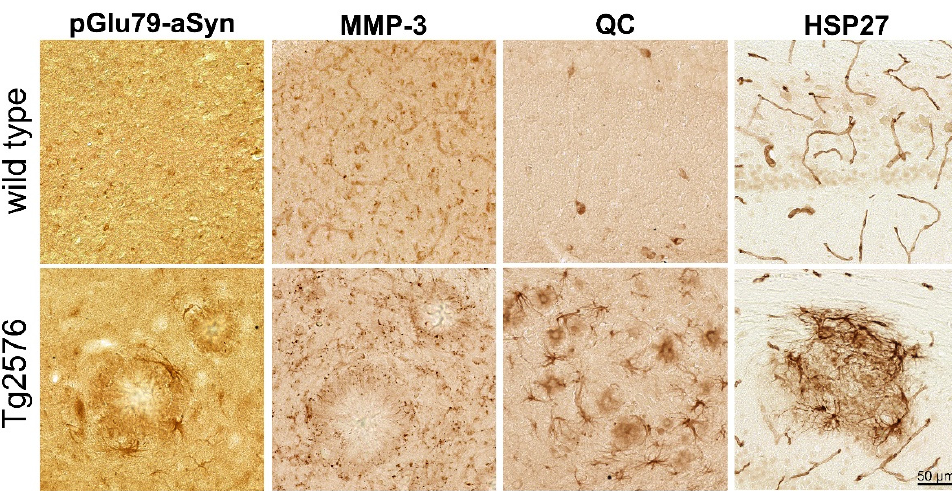
Figure 3 . Immunohistochemical detection of pGlu79-aSyn, MMP-3, QC and HSP27 in brains of wild-type and Tg2576 mice . In wild-type mouse brain ( top row ), synaptic pGlu79-aSyn, extracellular/synaptic MMP-3, QC-positive interneurons and vascular HSP27 were detected. In contrast, in Tg2576 mouse brain ( bottom row ), pGlu79-aSyn, QC and HSP27 were detected with different intensities in glial cells. MMP-3 and in addition QC and pGlu79-aSyn appeared as punctate or diffuse extracellular aggregates in the periphery of A β plaques. The examples shown are from entorhinal cortex (pGlu79-aSyn and MMP-3) and from hippocampus (QC and HSP27).